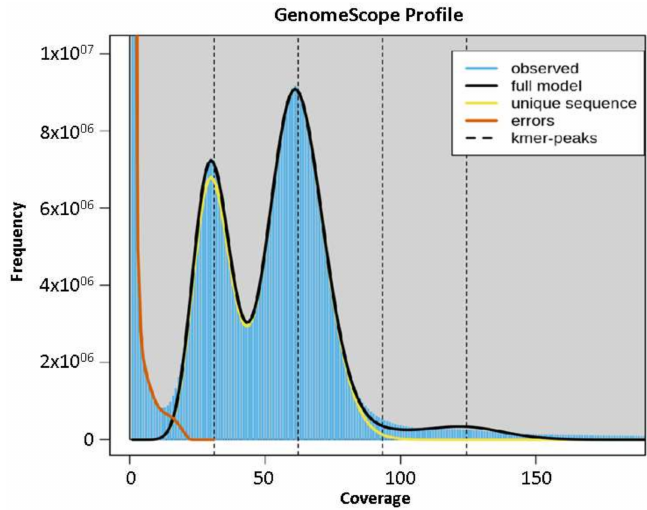
Figure 1. K-mer graph of abaca var. Abuab genome assembly.